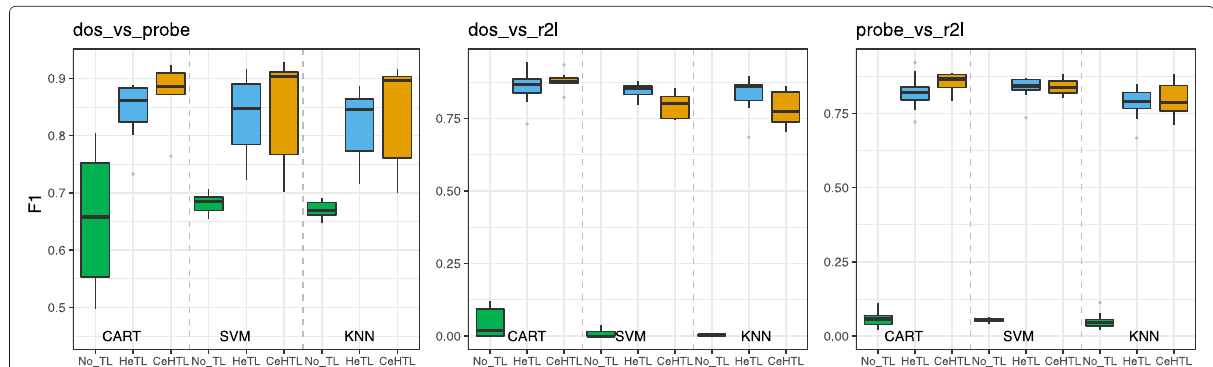
Fig. 3 Box plot of F 1 score of transfer learning approaches and baselines on three main